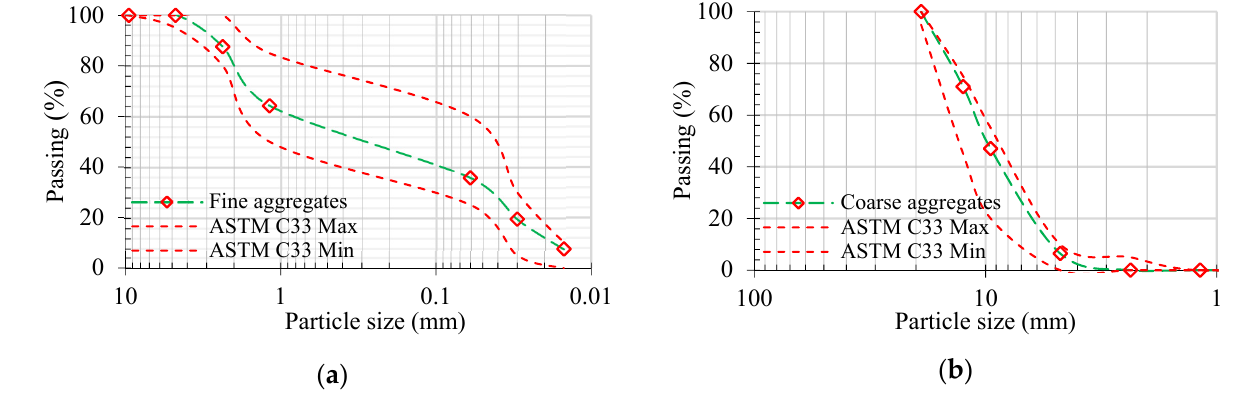
Figure 1. Sieve analysis of ( a ) fine aggregates ( b ) coarse aggregates. Table 1. Several features of coarse aggregates. Table 2. Mix design of GFGC.